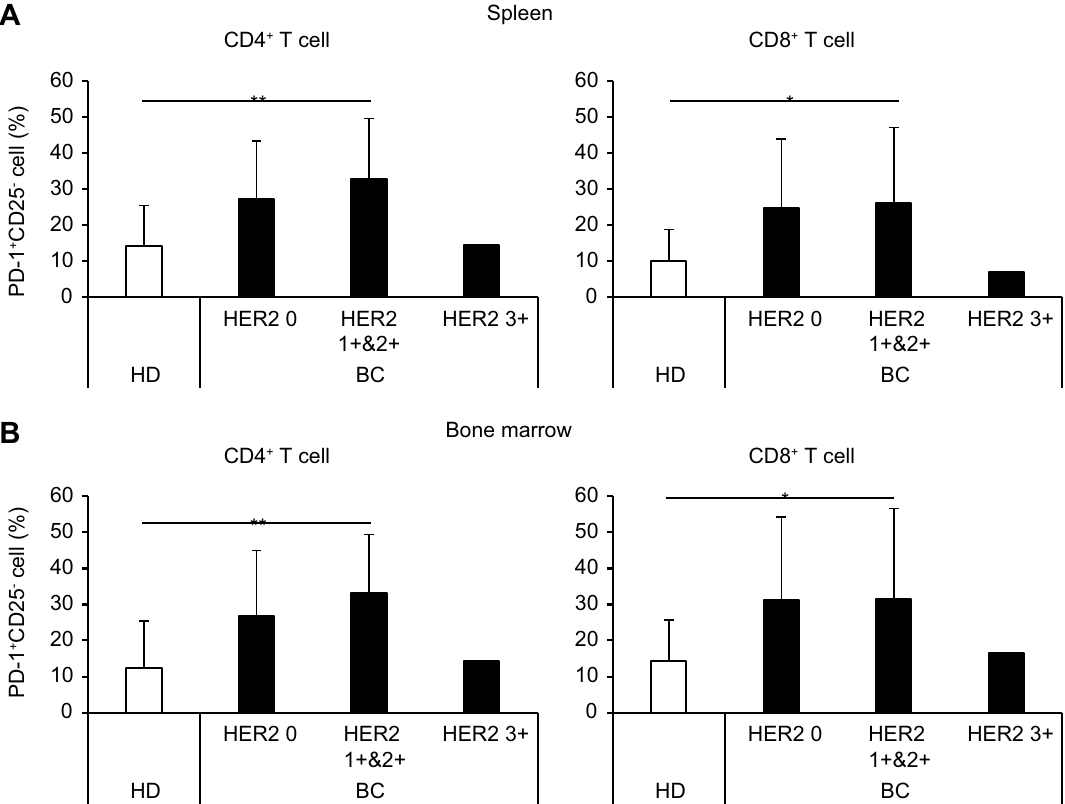
Figure 2. Exhaustion T cells were abundantly detected in HER2-low BC-M. Frequency of PD-1 + CD25 − subset in CD4 + or CD8 + gated T cells in the spleen (A) and bone marrow (B) of NOG-hIL-4-Tg mice transplanted with HD ( n = 22) or BC (HER2 0; n = 3, HER2 1 + &2 + ; n = 8, HER2 3 + ; n = 1) PBMCs. HD and BC-transplanted mice are indicated as white (HD) or black bars (BC). * p = 0.05, ** p = 0.01. BC breast cancer; HD healthy donor; HER2 Human epidermal growth factor receptor 2; PBMCs peripheral blood mononuclear